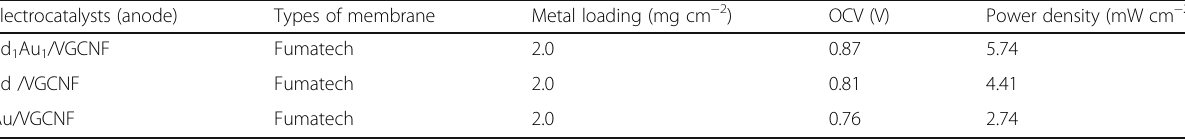
Table 5 Single cell output power density in mW cm − 2 at different NaOH concentration solutions Electrocatalysts (anode) Types of